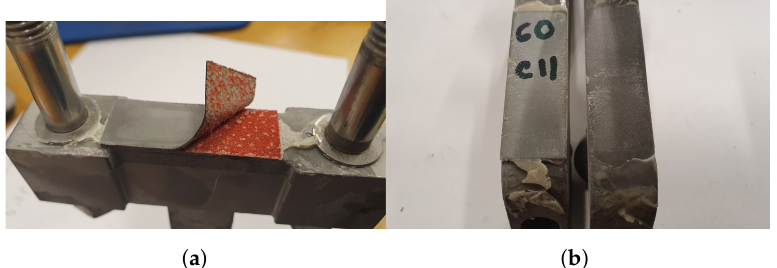
Figure 9. A mixed mode failure is presented in ( a ), where both a core failure and an adhesive failure has occurred. In ( b ), an adhesive failure is